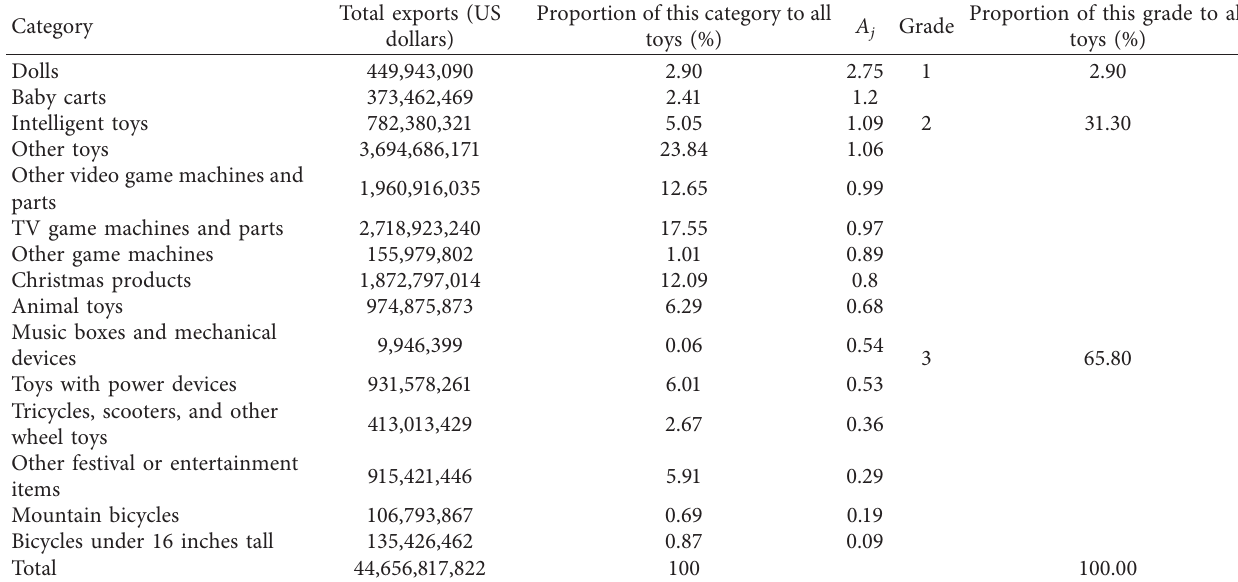
Proportion of this grade to all Total exports (US Proportion of this category to all A j Grade toys dollars) toys (%)